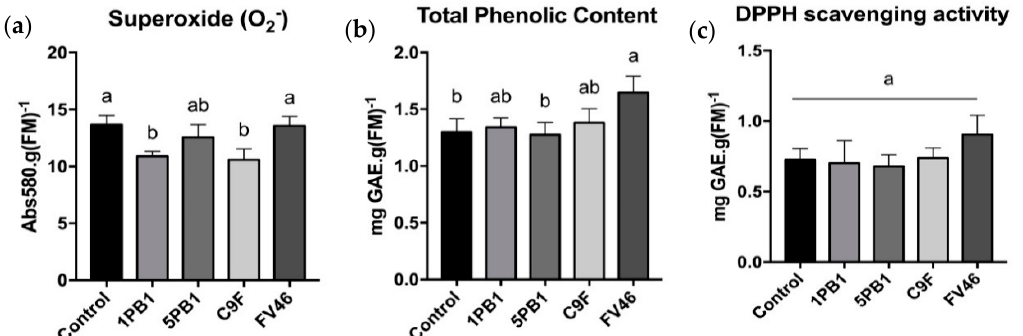
Figure 5. Effects of Inoculations with 1PB1, 5PB1, C9F and FV46 leaf redox status of 130 days-old tomato plants: ( a ) superoxide (O 2 − ) content, ( b ) total phenolic content, ( c ) DPPH-scavenging activity. Presented values are means ± SD (n = 3) of measurements on each treatment group. Means with the same letter are not significantly different according to the Dunnett test ( p < 0.05).